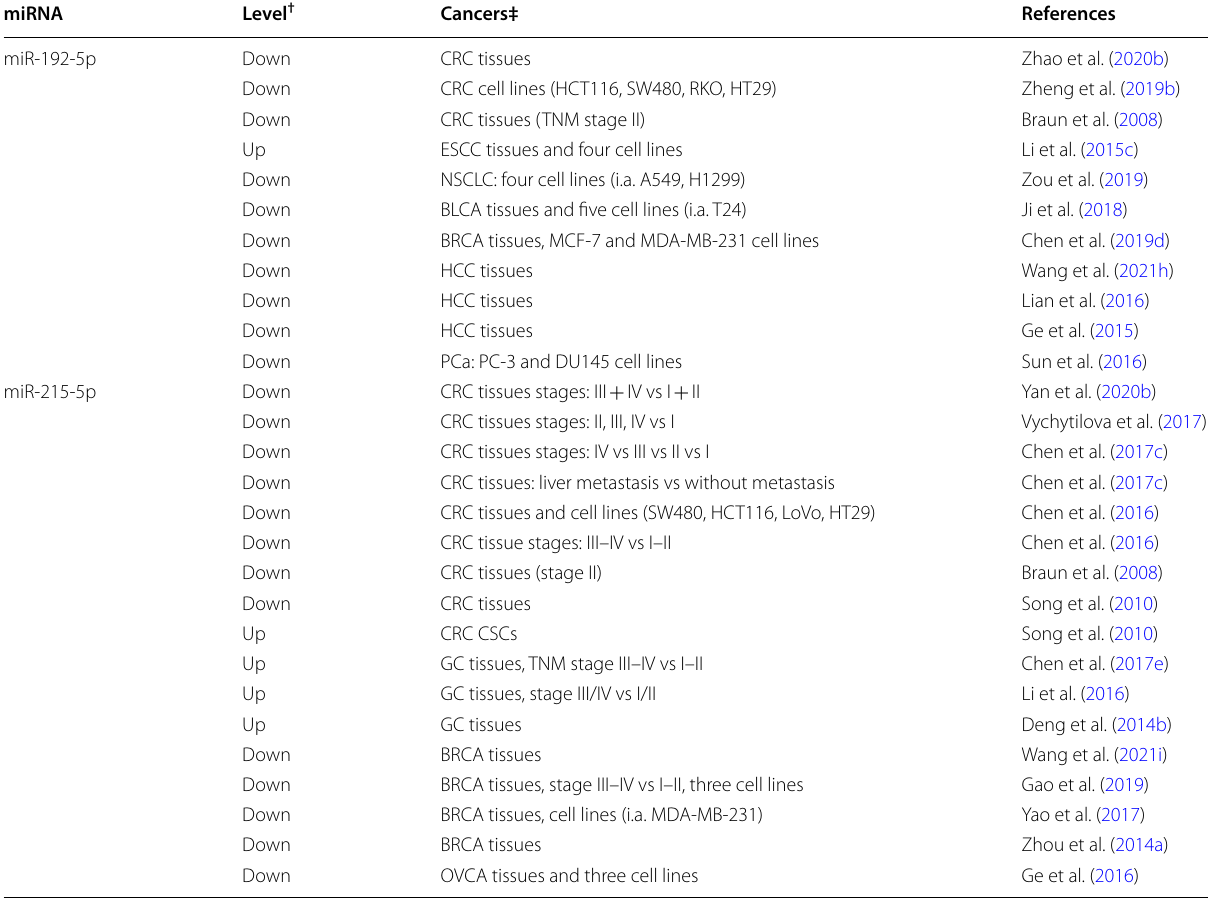
Table 2 Expression levels of miRNAs targeting i.a. TYMS mRNA in